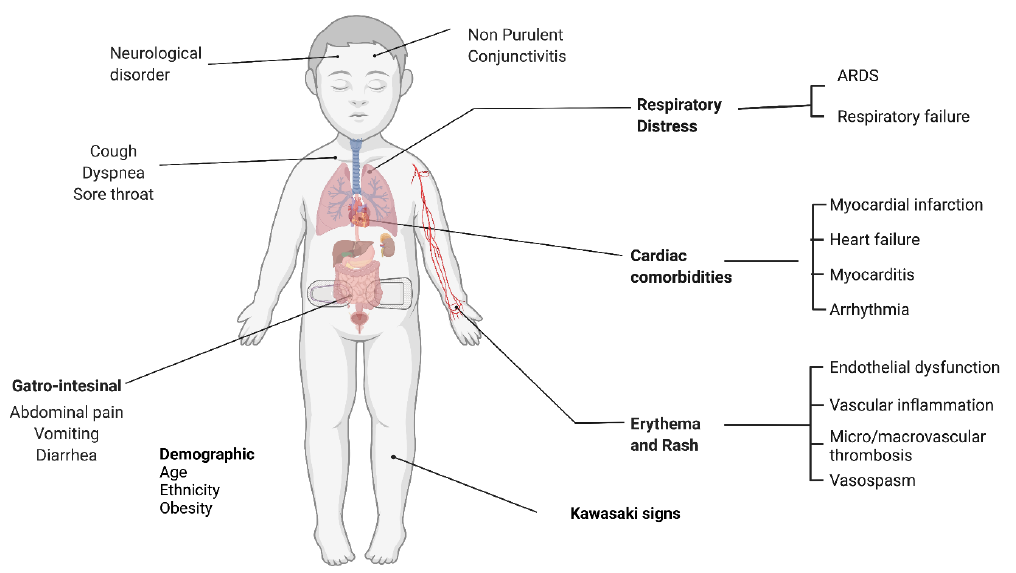
Figure 2. Organs affected in MIS-C immunopathological disorder in children. This disorder affects multiple organs and shows a systemic immune response. It mainly causes respiratory distress, cardiac comorbidities, gastrointestinal upset, and vascular dysfunction. This disorder is associated with demographic features such as various age form, ethnicity, and obesity level.